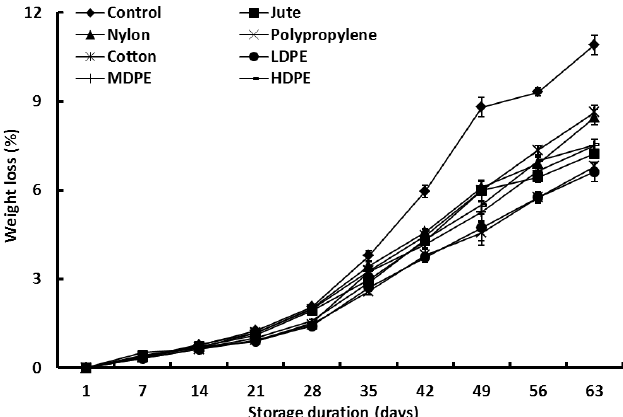
Fig. 1: Weight loss in potato tubers stored using different packaging mate- rials was highest throughout the storage period when stored in po- lypropylene and LDPE packages. Vertical bars show ±SE of means (n-3). Interaction between storage intervals and packaging materials was significantly different at p ≤ 0.05.